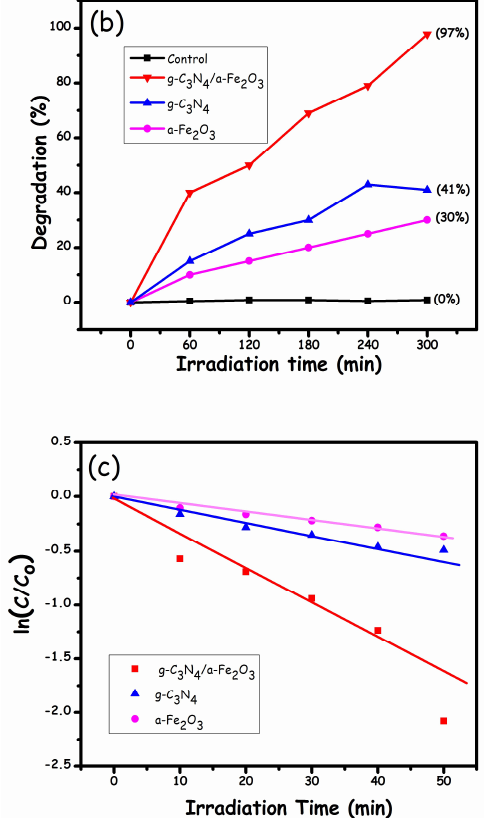
Figure 7. ( a ) Plot of C/C o vs. time. ( b ) The corresponding degradation efficiency of MO removal. ( c ) Plot of ln (C/C o ) vs. time.